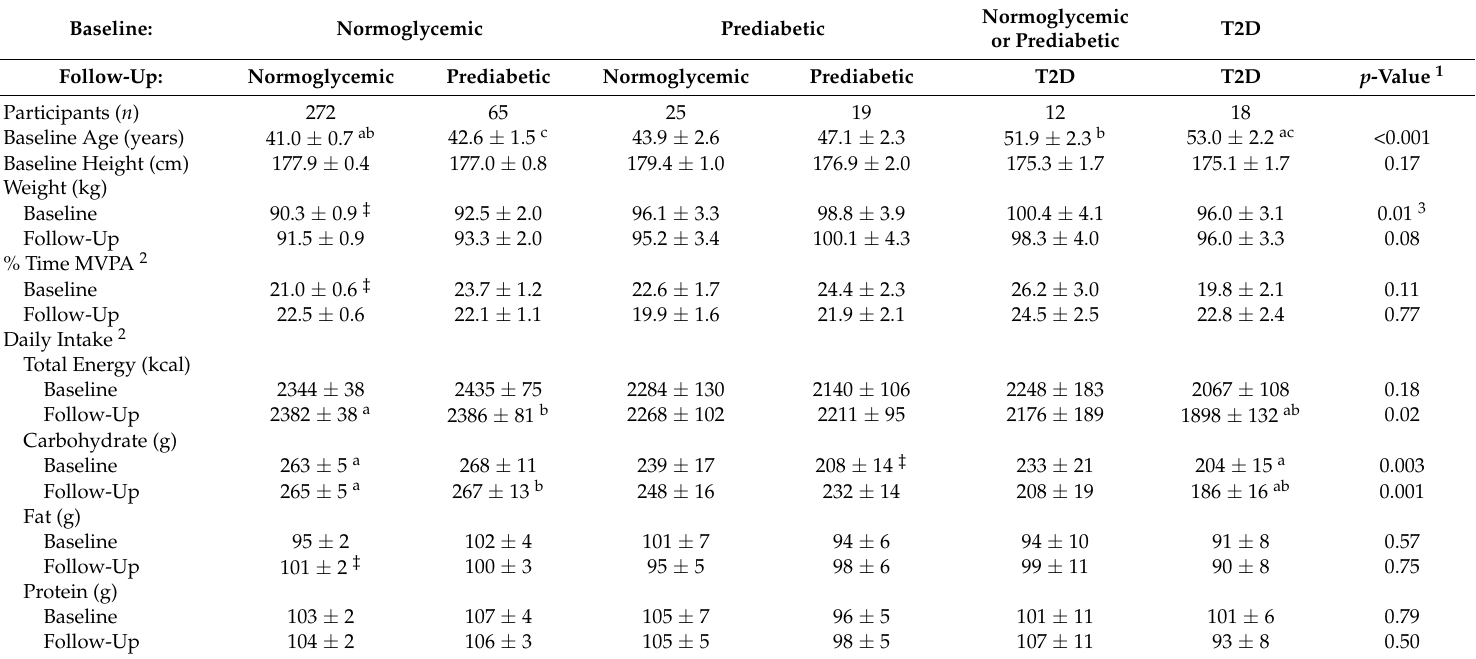
Table 2. Anthropometrics, activity levels, and diet intake of the 411 men from the South Dakota Rural Bone Health Study cohort, according to glycemic categories after three years of